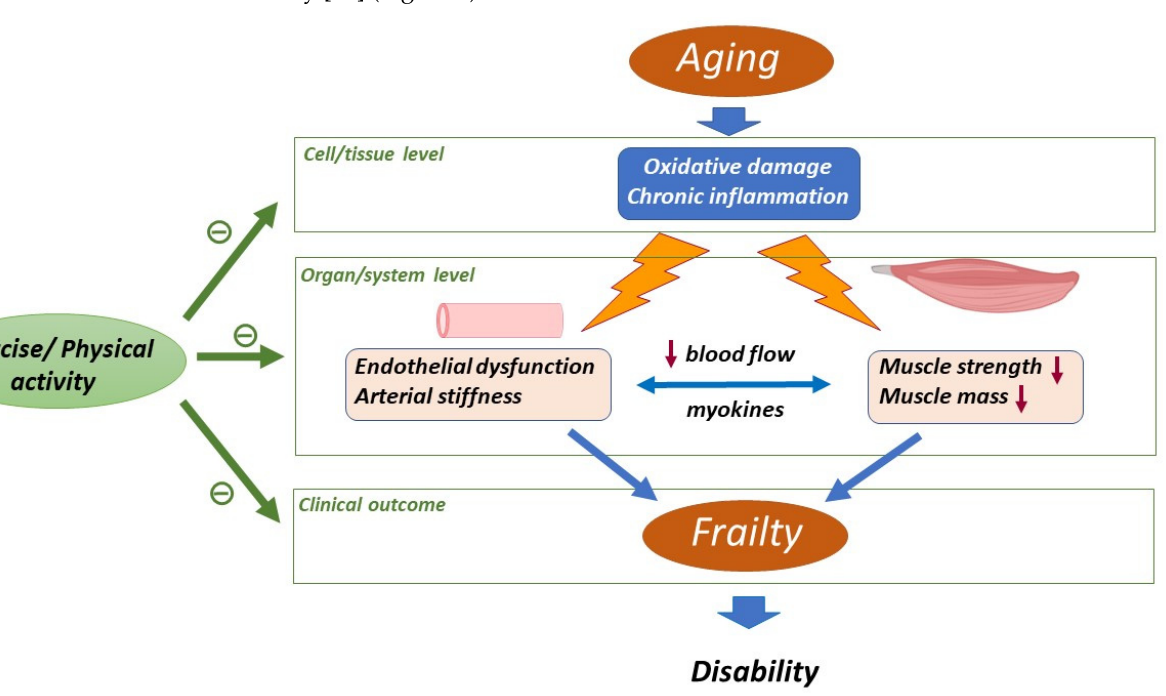
Figure 1. Positive effects of physical activity/exercise on aging-related functional outcomes are evidenced at different levels.